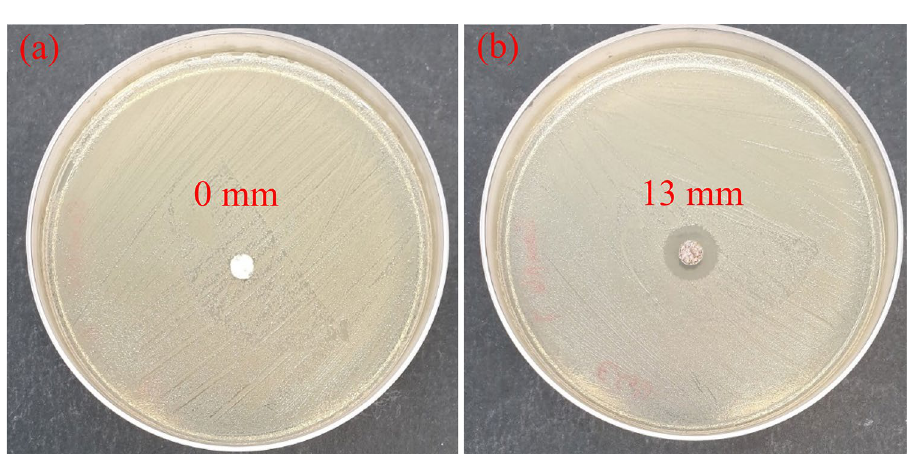
Figure 10. Bactericidal properties of ( a ) raw HNTs and ( b ) HNTs functionalized by iron oxide and silver nanoparticles towards the gram-negative E.coli bacteria.